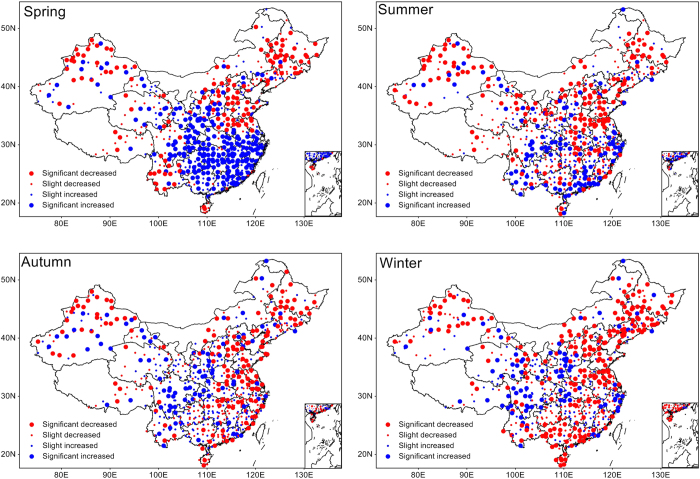
Trends tests.Linear trends in %HDD for different seasons from 1971–2013. The %HDD was calculated from 215 values (5 × 43yr) based on 5-consecutive-day moving windows centered on each calendar day and 90th percentile thresholds from 1971–2013. The linear trend in %HDD was examined with linear regressions. Slopes were considered significant for p < 0.05. Red dots indicate negative trends, and blue dots indicate positive trends. The map was generated with MeteoInfo 1.1.3 (http://www.meteothinker.com/).